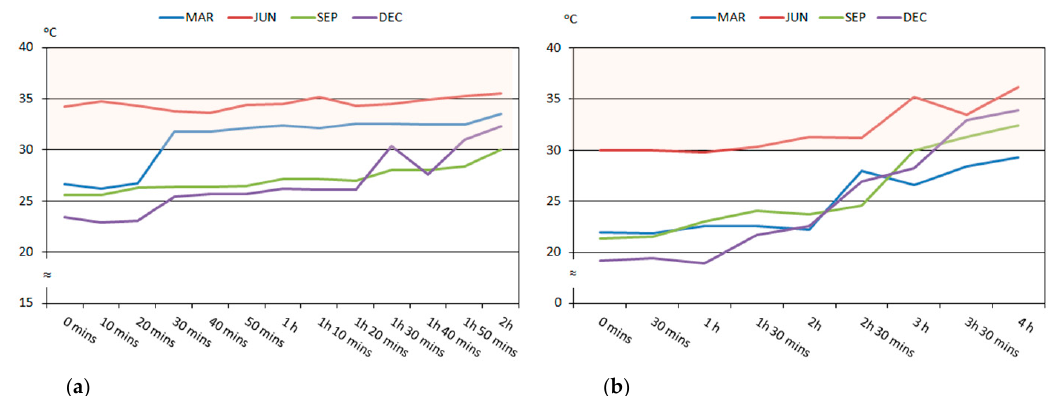
Figure 12. Seasonal events mPET variation by time for runners ( a ) and walkers ( b ).